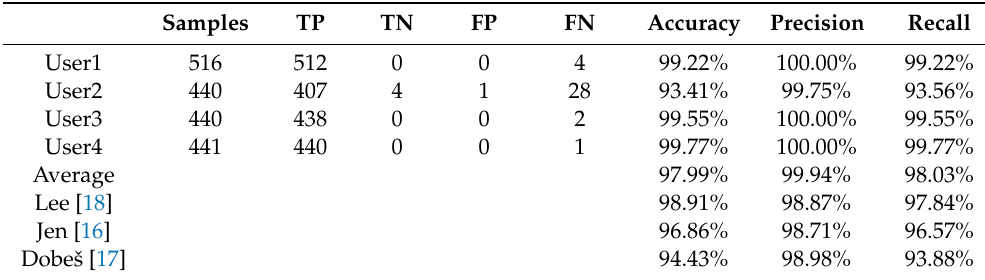
Table 6. Eye detection result.